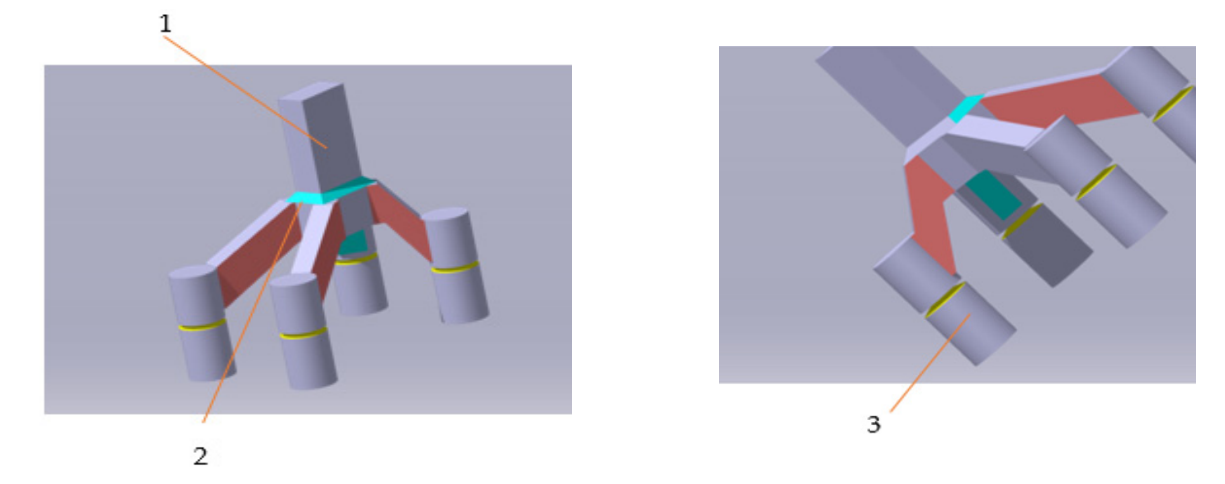
Figure 1. Rod assembly—tetrapod: 1—aluminum bar; 2—bimetal plate; 3—rondon. A 4-branched branch is welded to the steel plate, which is called a tetrapod. The overall dimensions of the tetrapod are: 800 × 500 × 500 mm 3 . At the end of each branch is welded perpendicular to the tetrapod, a steel bar made of S355JR steel, with a diameter of Ø = 124 mm and a length of 230 mm—rondon.